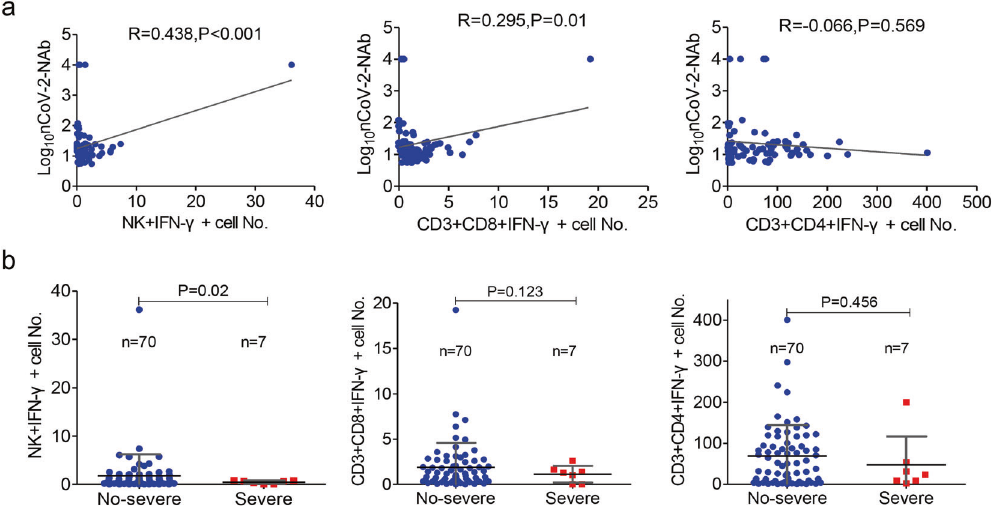
Fig. 7 SARS-CoV-2 antigen-activated cellular immune responses associated with antibodies. a Correlation between the neutralizing antibody (Nab) and the number of antigen-speci fi c NK cells, CD3 + CD8 + cells, and CD3 + CD4 + cells. b The number of antigen-speci fi c NK cells in the severe group was much lesser than that in the non-severe